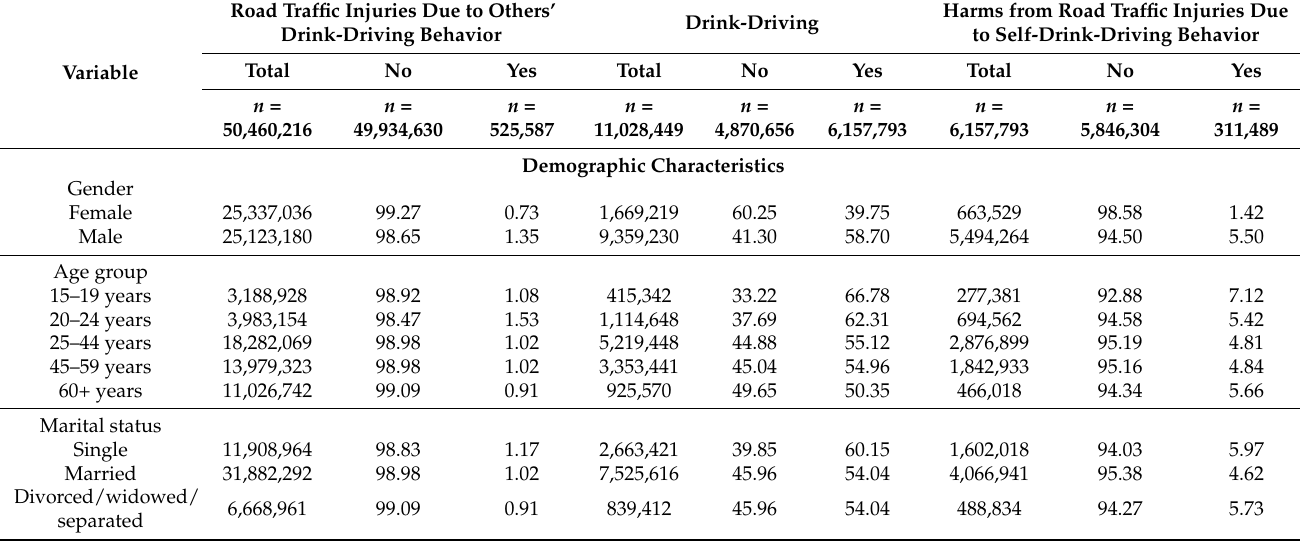
Figure 1. Proportion of reported drink-driving behavior and harms from road traffic injuries due to self- and others’ drink-driving behavior. Table 1. Descriptive results of demographical characteristics, socio-economic, drink-driving behavior, and harm from road traffic injuries due to self-drink- driving and others’ drink -driving behavior.